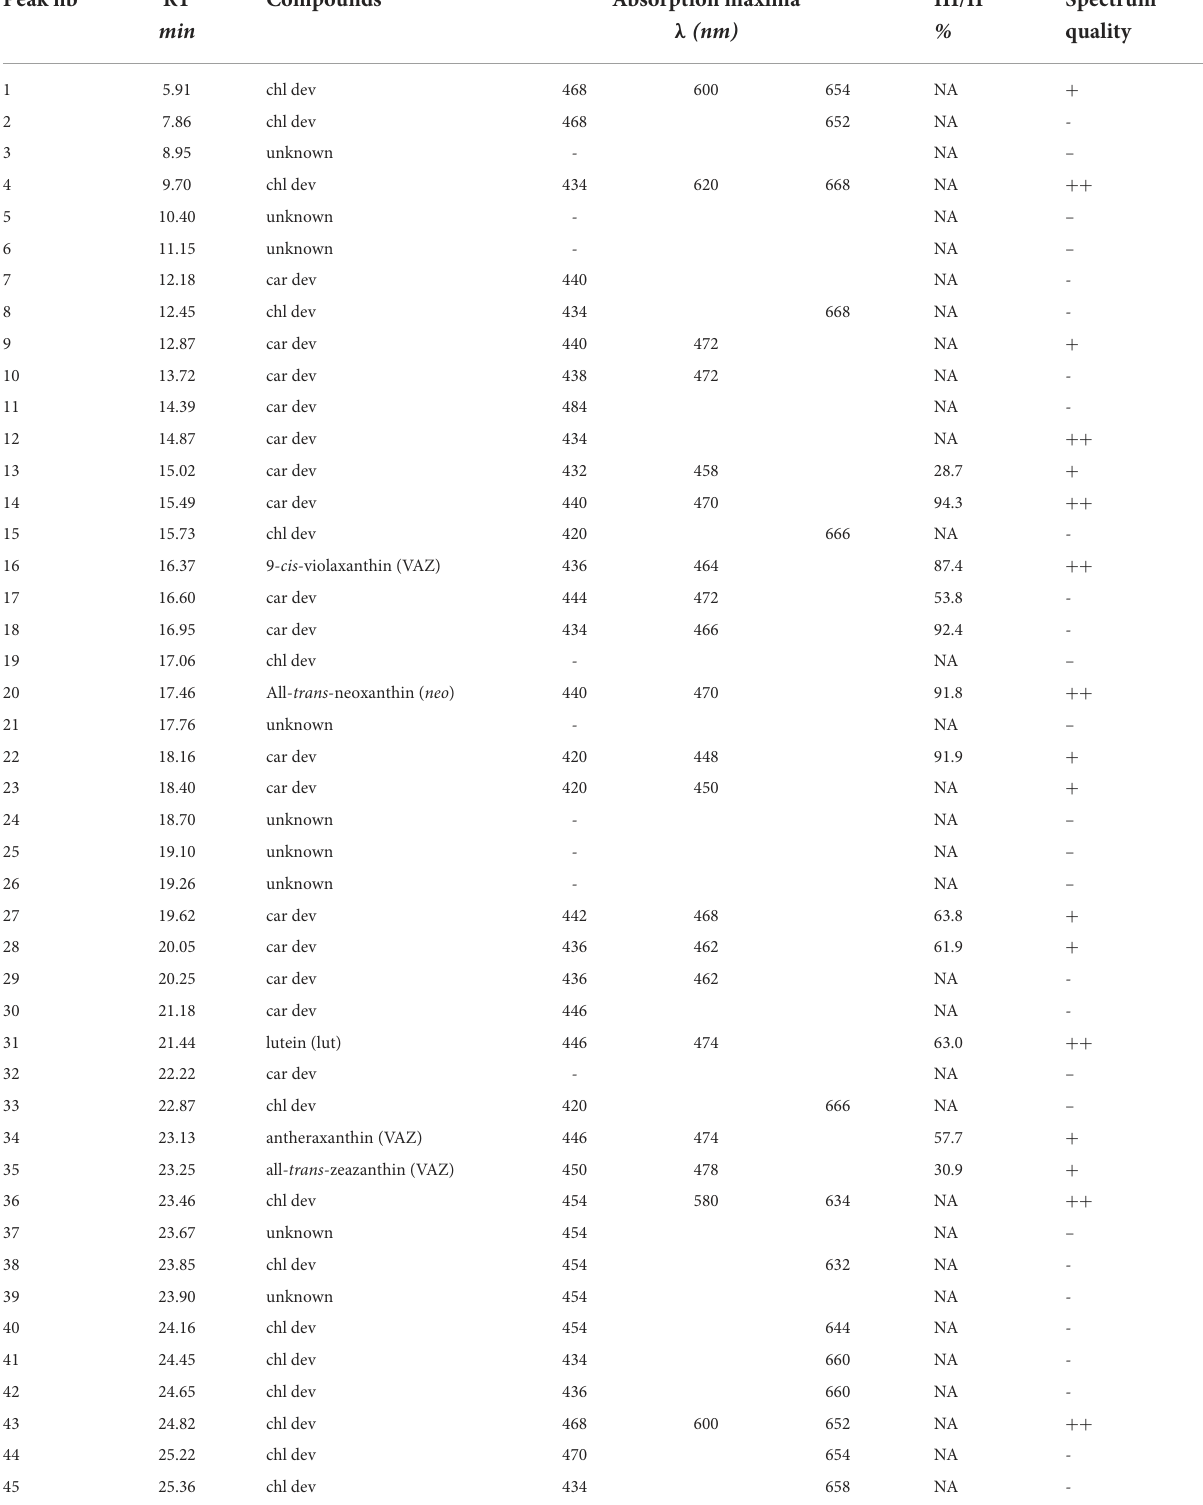
TABLE 2 Table indexing retention times, pigment groups, absorbance maxima of each peak, and %III/II ratios that were observed in the chromatogram of spinach leaves. Peak